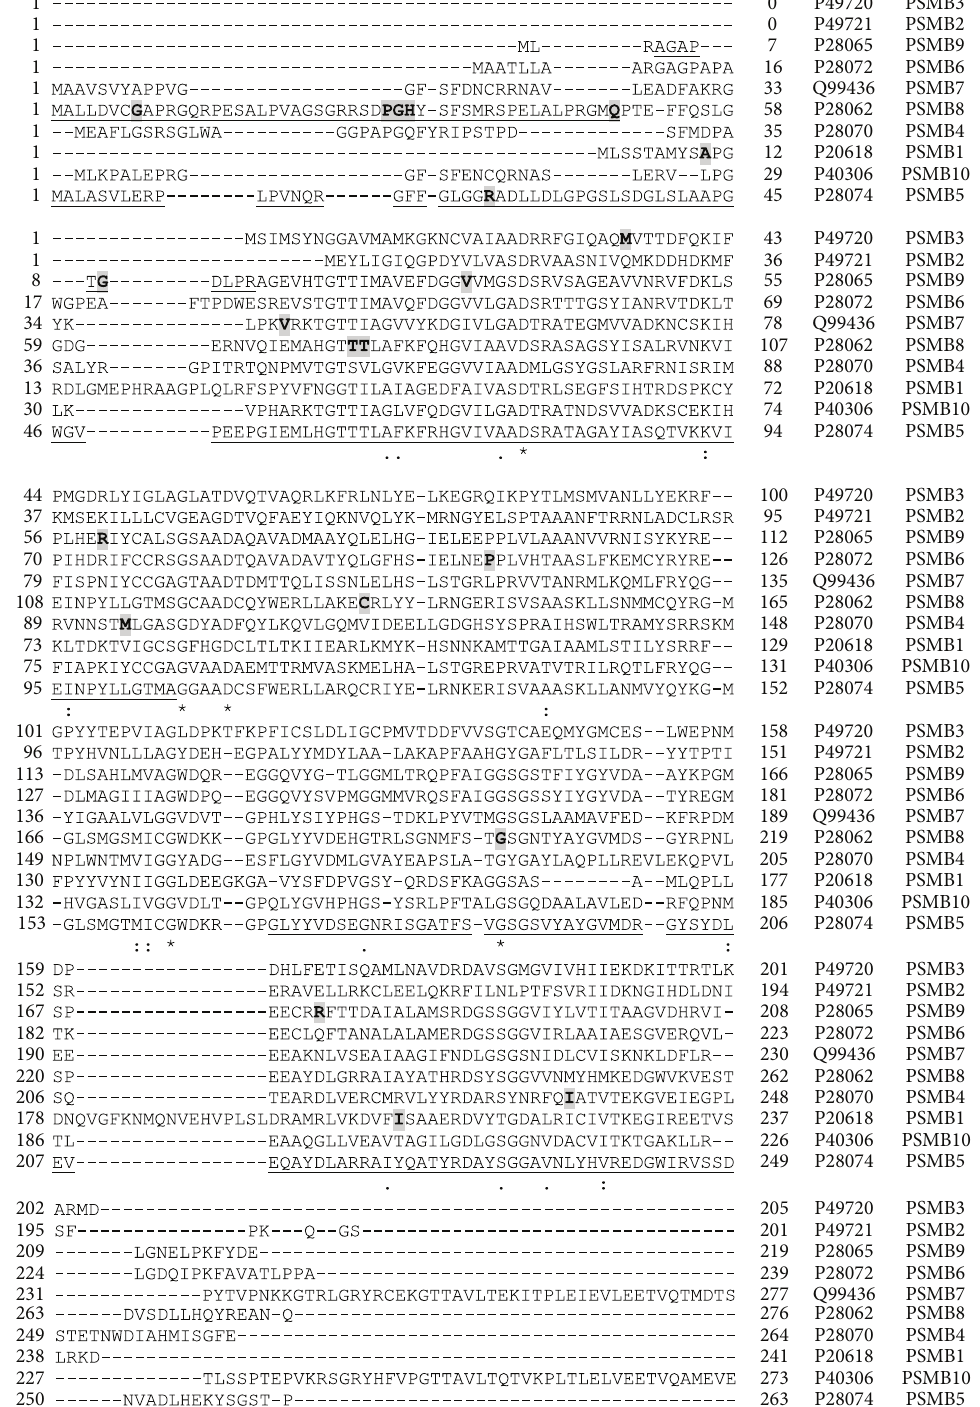
Figure 5: Alignment of human PSMB subunits 1–10. Protein sequences of the ten proteasome PSMA subunits were aligned using Clustal W. ⋆ , identical residue in all ten subunits; :, conserved amino acids with strongly similar properties; ., conservation between residues of weakly similar properties. Naturally occurring variants are highlighted with grey boxes. Alternatively spliced regions are underlined. Amino acid residue numbers are shown on the left and right of each sequence and the UniProt accession number and gene name of each sequence are shown to the right of each